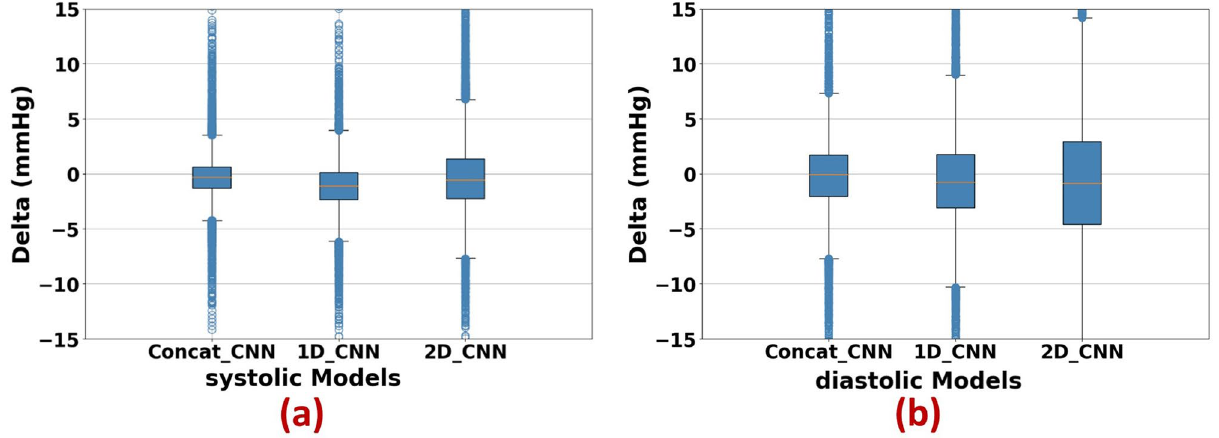
Figure 8. The box-and-whisker plot of estimation error for ( a ) SBP and ( b ) DBP.